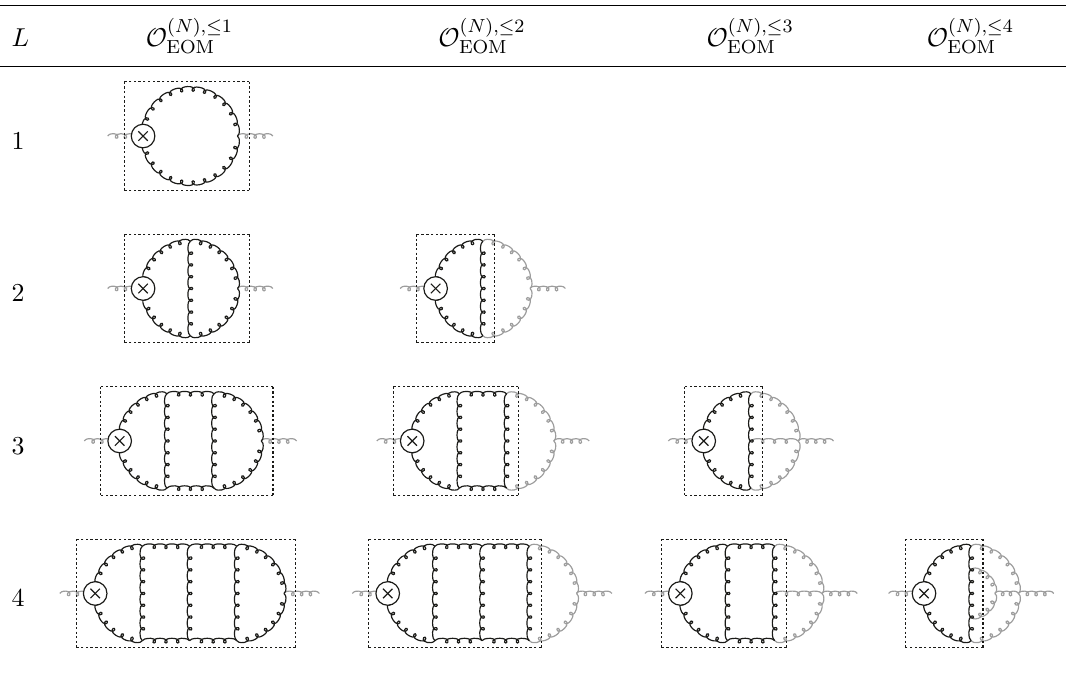
Table 1 . In the L th row the table gives examples of diagrams contributing to the L -loop contri- bution to Γ ( N ) . Subgraphs whose UV-counterterms require the various EOM operators O ( N ) ,k gg highlighted with dashed boxes.